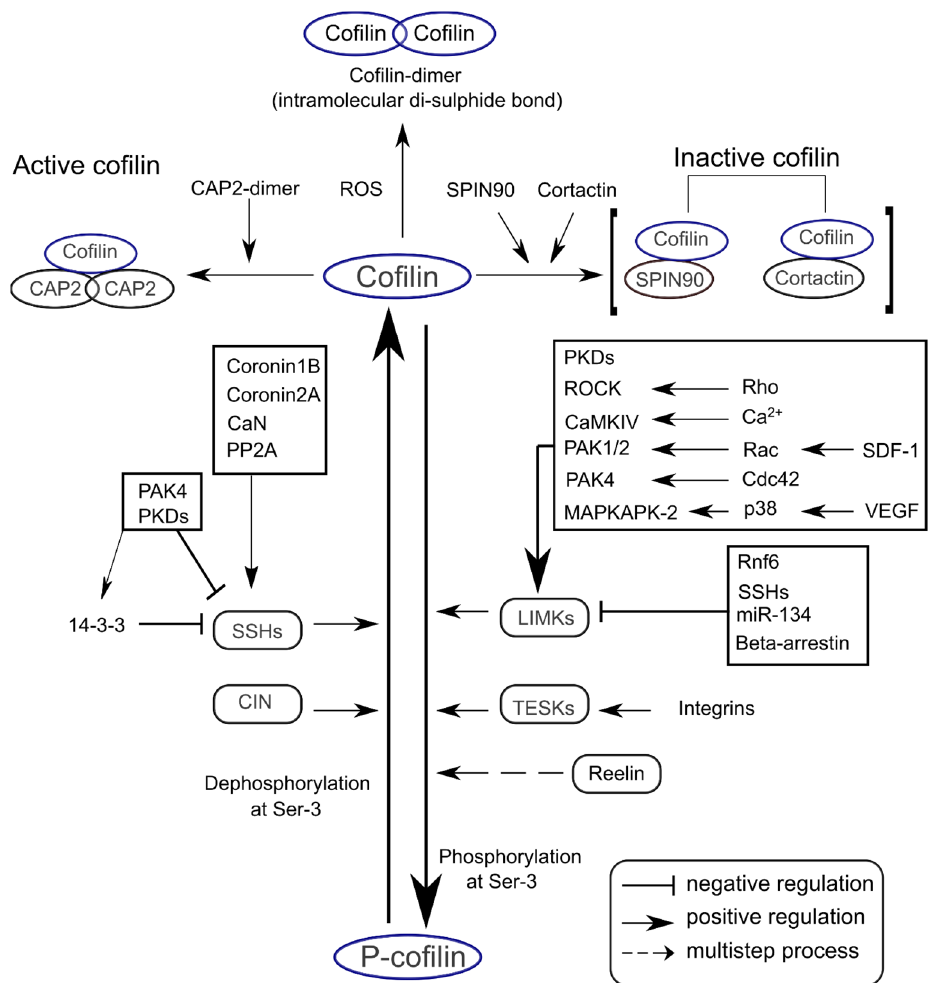
Figure 2. Signaling mechanisms regulating cofilin activity in the CNS. Cofilin can be dephosphorylated at the Ser-3 residue by SSHs and CIN. Cofilin Ser-3 phosphorylation is mediated by LIMKs and TESKs. These phosphatases and kinases can be activated or inhibited by diverse upstream regulators. Cofilin activity is enhanced through binding with CAP2 dimers (upper left), while binding with SPIN90 or cortactin decreases cofilin activity (upper right).